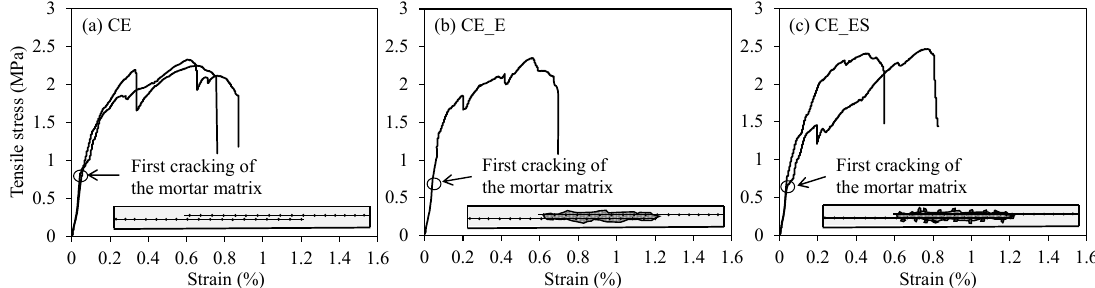
00.511.522.53 Figure 12. Tensile stress–strain relationship of TRM coupons with different surface treatments in the chloride environment: ( a ) coupons without surface treatment; ( b ) coupons impregnated by epoxy; ( c ) coupons coated with aluminum oxide powder after epoxy impregnation. Figure 13. Effects of different surface treatments on the tensile behavior of TRM coupons in the chloride environment: ( a ) cracking and ultimate strength; ( b ) initial stiffness; ( c ) ultimate strain.